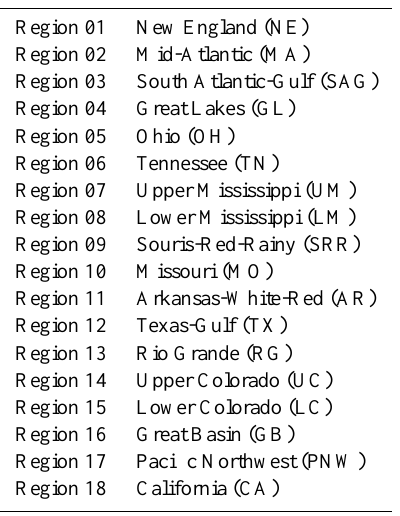
Table 1. List of USGS water-resources